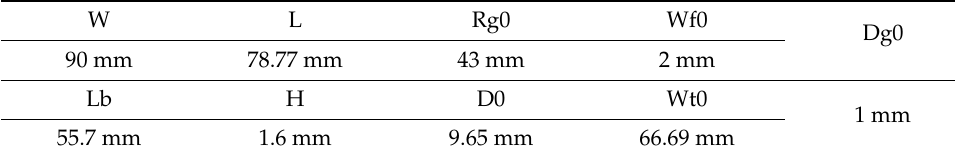
Table 2. Geometrical parameters of proposed slot antenna 2.